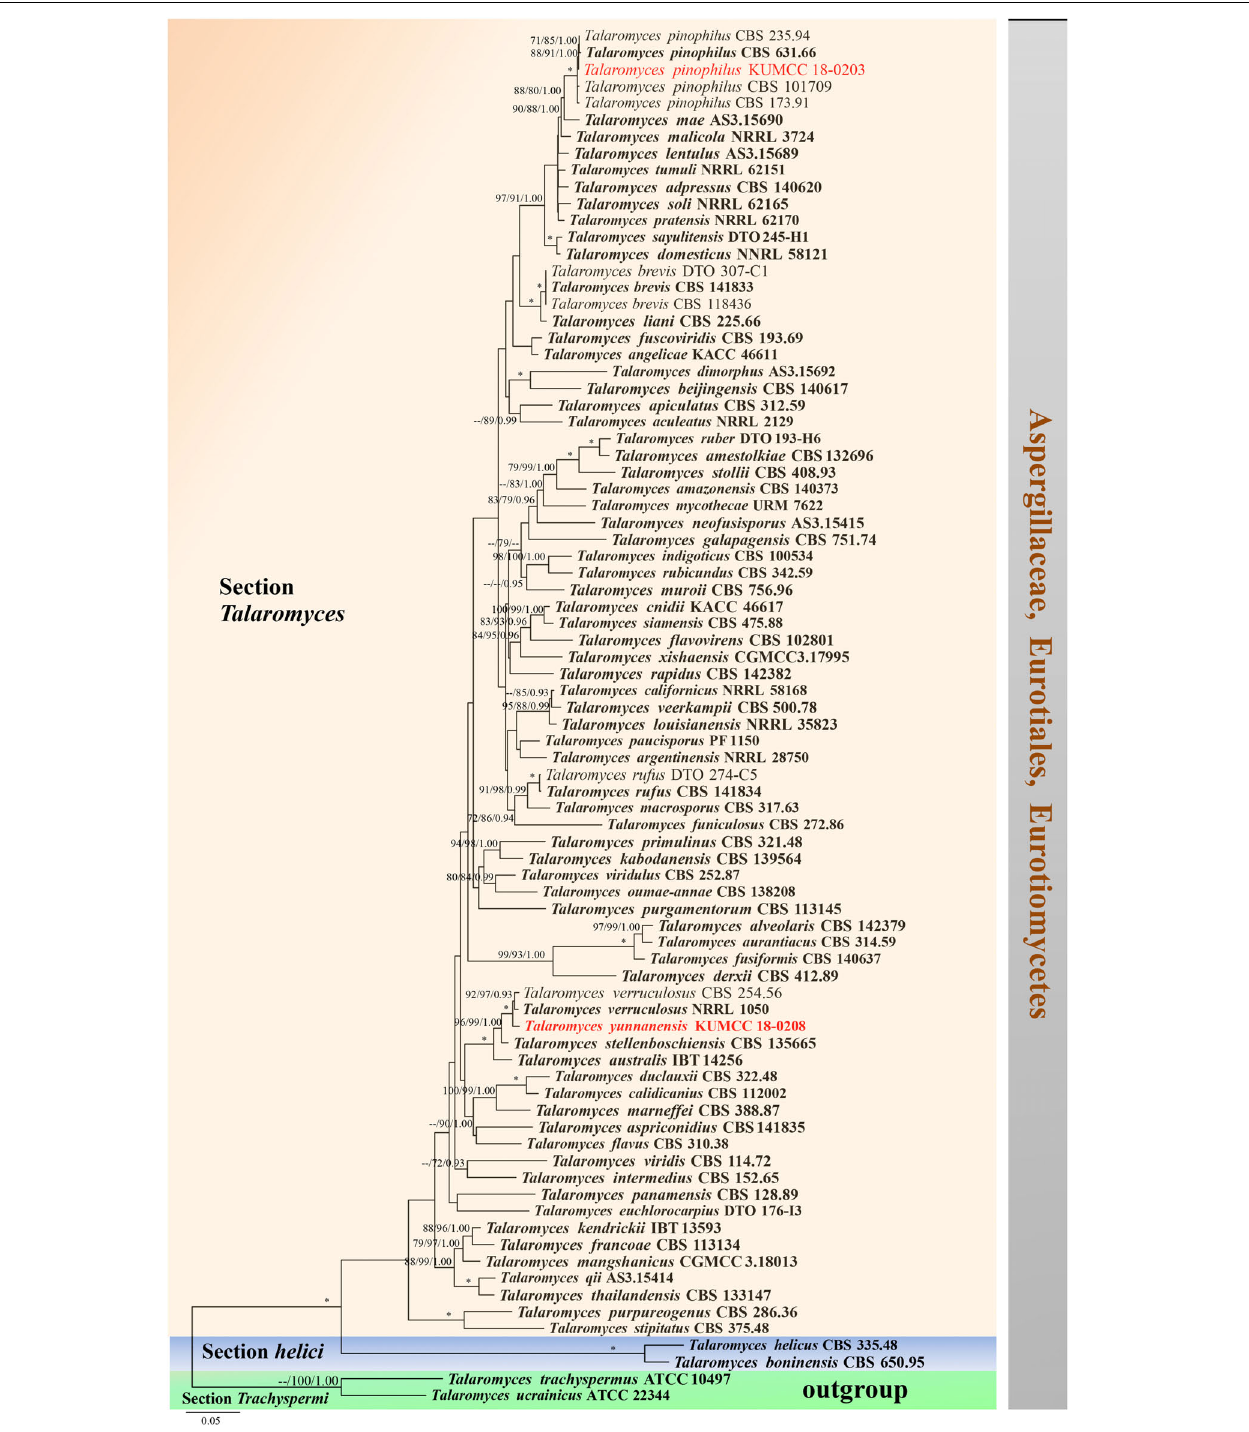
FIGURE 15 | Phylogram generated from maximum likelihood analysis based on combined ITS, BenA , CaM, and RPB2 sequence data. Eighty-two sequences are included in the combined analysis, which consisted of 2858 characters including alignment gaps. The tree is rooted to Talaromyces trachyspermus (ATCC 10497) and T. ucrainicus (ATCC 22344). The MP analysis for the combined dataset had 857 parsimony informative, 1552 constant, 176 parsimony uninformative characters and yielded 46 most parsimonious trees. The best-fit model SYM + I + G was selected for CaM , GTR + I + G for ITS and HKY + I + G for RPB2 and BenA in BI analysis. Maximum parsimony and maximum likelihood bootstrap values ≥ 70% and Bayesian posterior probabilities ≥ 0.90 (MPBS/MLBS/BYPP) are indicated at the nodes. Branches with 100% MPBS, 100% MLBS and 1.00 BYPP values are indicated as an asterisk ( ∗ ). The ex-type strains are bolded black, and the new isolates are in